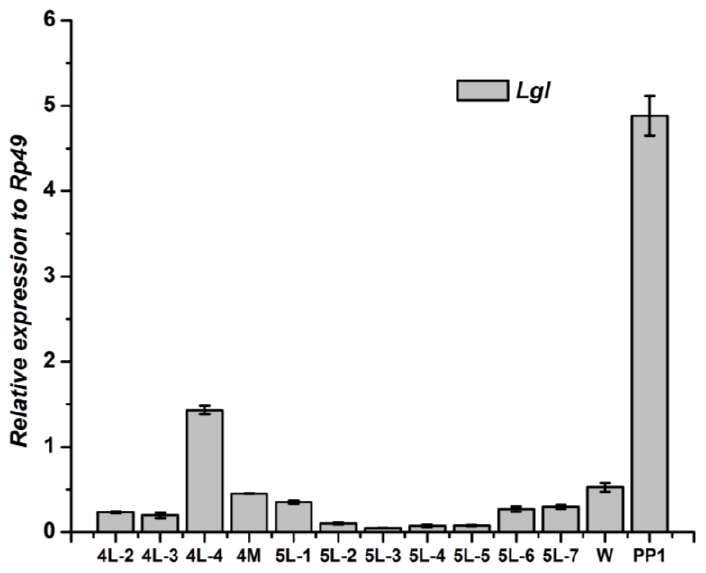
Figure 9. Developmental changes of Lgl mRNA in fat body of Bombyx